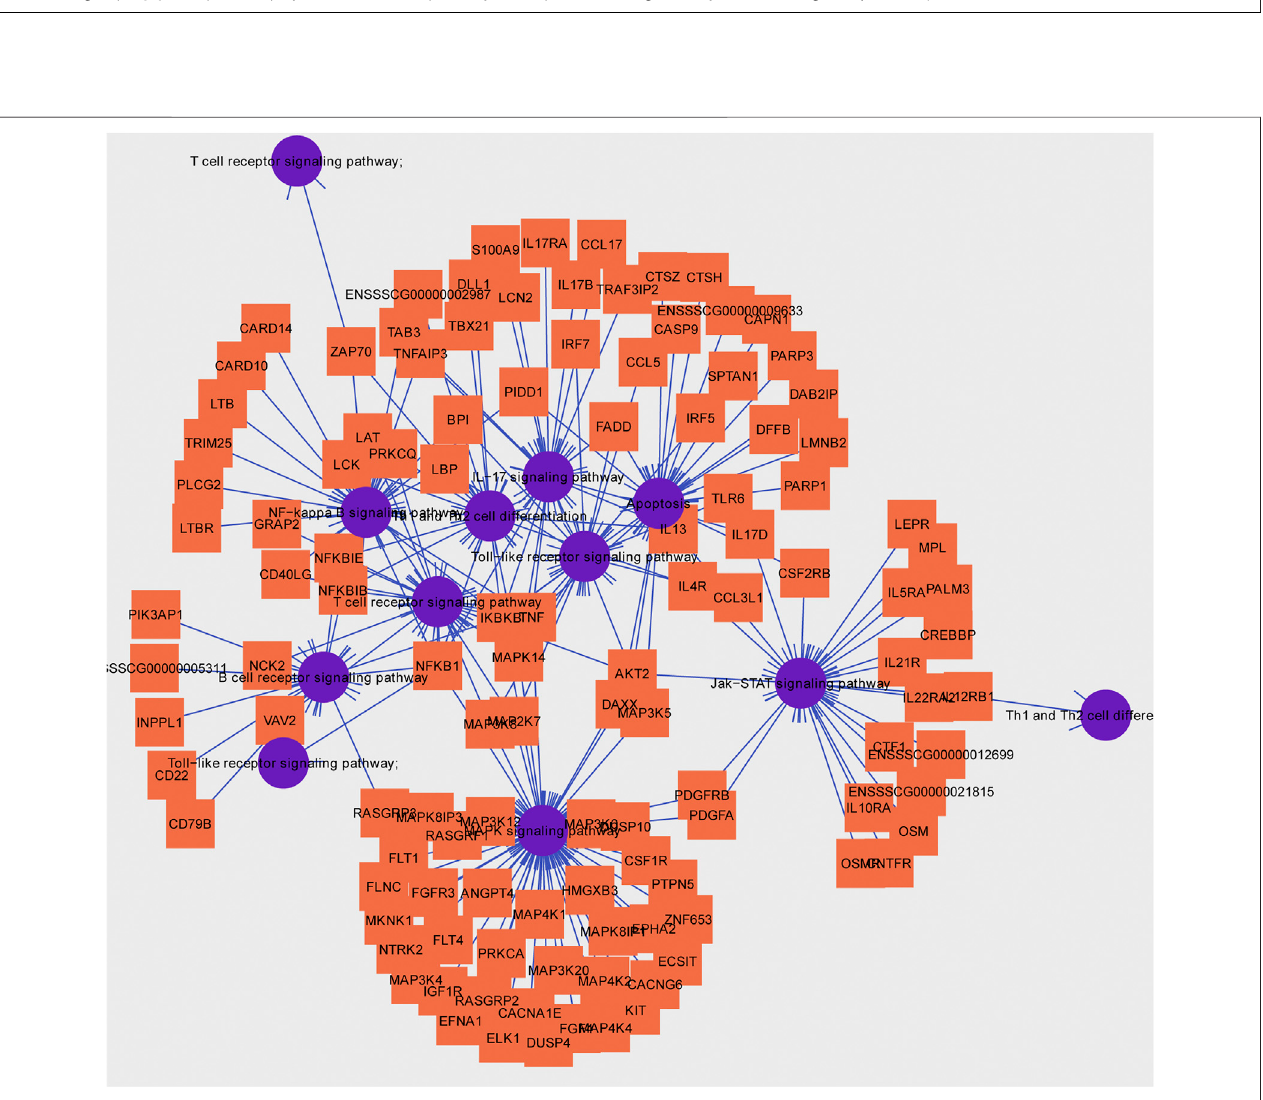
Frontiers in Genetics |